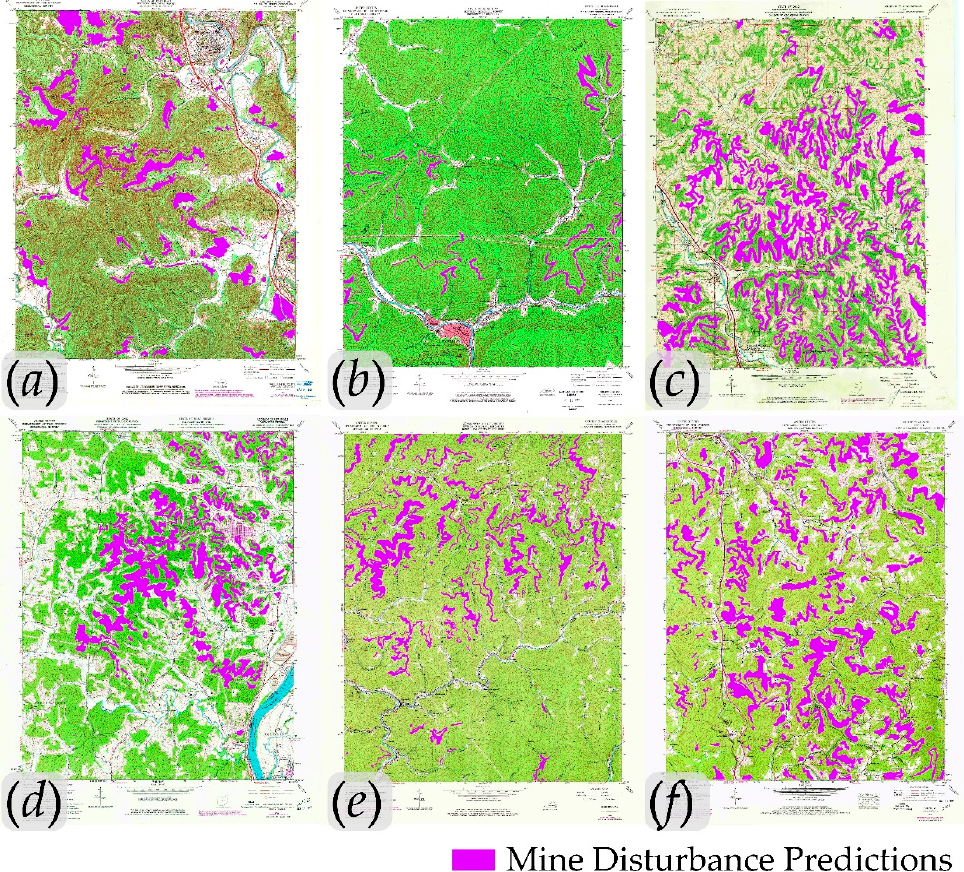
Figure 8. Example predicted mine disturbance results for entire 1:24,000-scale quadrangles ( a ) Quad = Williamsburg, State = KY, Year = 1969, SCANID = 710018; ( b ) Quad = Pineville, State = KY, Year = 1974, SCANID = 709535; ( c ) Quad = Macksburg, State = Ohio (OH), Year = 1961, SCANID = 225684; ( d ) Quad = Addison, State = OH, Year = 1960, SCANID = 224689; ( e ) Quad = Gundy, State = Virginia (VA), Year = 1963, SCANID = 185241; ( f ) Quad = Pound, State = VA, Year = 1957, SCANID = 186333. Topographic maps obtained from the USGS and the National Map’s Historical Topographic Map